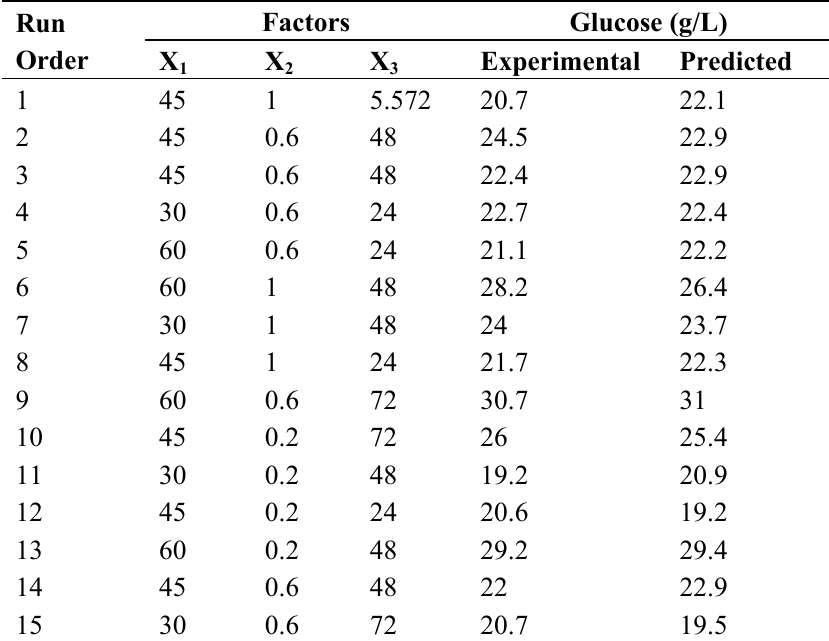
Table 4. Box–Behnken design matrix for the three factors and their experimental results for